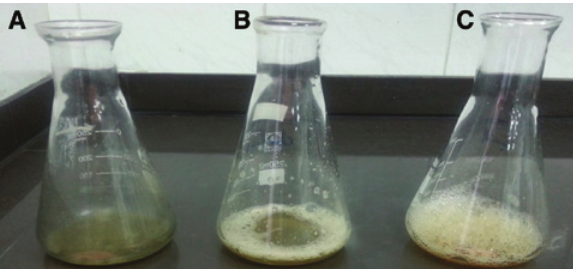
Figure 1: Generated foam by shaking the saponin extract from the Ziziphus spina-christi leaves using (A) ethanol, (B) methanol (C) and